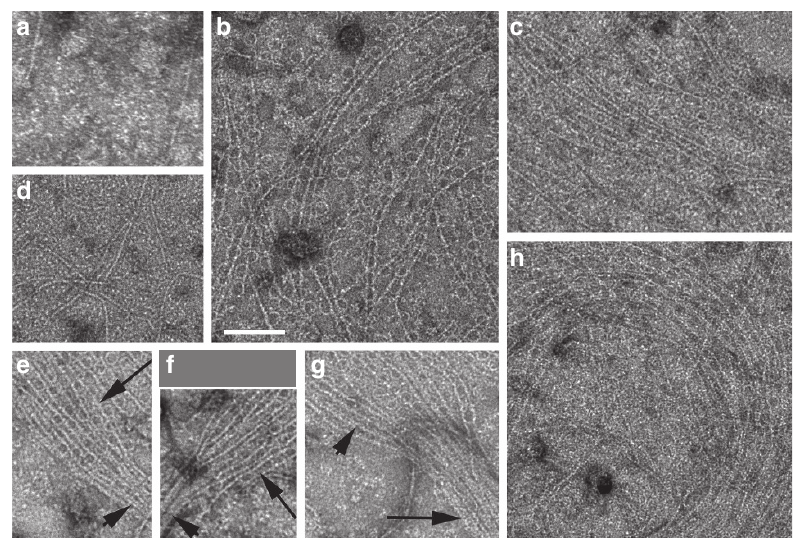
Figure 4 | Assembly of FtsZ on monolayers seeded with FtsA. ( a ) Mock experiment in which 5 m M FtsZ is added to monolayers, but no FtsA was present; ( b ) 0.1 m M FtsA þ 5 m M FtsZ; ( c ) 0.5 m M FtsA þ 5 m M FtsZ; ( d ) 0.5 m M FtsA þ 5 m M FtsZ on a grid without a monolayer. ( e – g ) Same conditions as ( c ), showing examples of aligned unbundled FtsZ filaments (long arrows) on FtsA minirings merging with bundled FtsZ filaments not associated with visible FtsA minirings (short arrows). ( h ) A large swirl of aligned FtsZ filaments on FtsA minirings. ATP and GTP were added to all experiments. Scale bar,